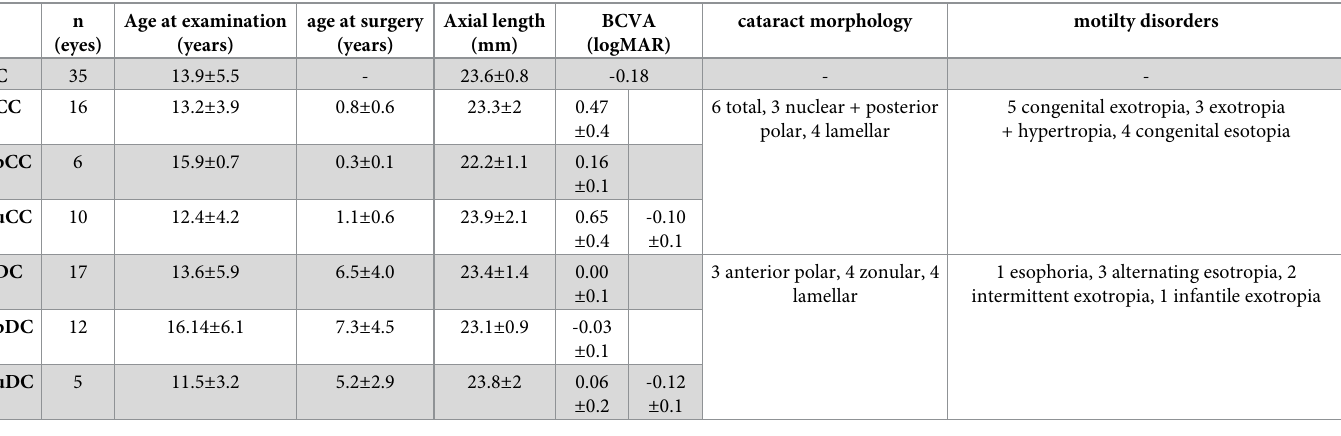
domain (SD) optical coherence tomography (OCT) (Spectralis SD OCT, Heidelberg Engineer- ing, Inc., Heidelberg, Germany). Patients’ selection was performed on the basis of the follow- ing exclusion criteria: presence of retinal (i.e. oedema, dystrophy, atrophy, retinopathy of prematurity), corneal or optical media disease (i.e. opacities, oedema), ocular abnormalities (i.e. microphthalmos, posterior- type persistent hyperplastic primary vitreous, persistent fetal vasculature), history of congenital glaucoma or systemic disorders able to influence learning ability, postoperative complications (i.e. retinal detachment, macular oedema, ocular inflam- mation), glaucoma and presence of nystagmus or fixation instability. Macular thickness analysis was performed in all patients using the internal fixation target, a 30x25˚ grid with 61 horizontal axial scans. Images with a quality index < 25 were excluded. Retinal thickness analysis algorithm provided mean thickness analysis of 9 areas, defined by the Early Treatment Diabetic Retinopathy Study (ETDRS) circle for every layer (Fig 1). The internal automated segmentation software (Fig 2) was used to obtain individual retinal layer thickness measurements including: overall retinal thickness (RT), nerve fibers layer (NFL), ganglion cell layer (GCL), inner plexiform layer (IPL), inner nuclear layer (INL), outer plexi- form layer (OPL), outer nuclear layer (ONL), and retinal pigment epithelium (RPE). Total reti- nal and single retinal layer thickness were analyzed at central 1mm, 3 and 6 mm of eccentricity in each sector ( n - nasal, i - inferior, t - temporal and s - superior). RNFL thickness analysis was performed with 3.5, 4.1 and 4.7 mm circle scan and thickness of each sector ( g- global, in- inferonasal, it- inferotemporal, st- superotemporal and sn- supero- nasal) was analyzed. Comparisons between macular and RNFL thickenss of congenital cataract, development cataract, contralateral eyes in unilateral CC and DC group (CCc and DCc respectively), con- trols, bilateral and unilateral CC and DC were performed. Only right eyes of control group were considered for statistical analysis. The study followed the tenets of the Declaration of Helsinki and an informed consent to participate in the study was obtained from all subjects, or their parents, after full explanation of the aims and modalities of the investigation. This study received an approval from Institu- tional Review Board of Molise University (n˚ 19/2021).